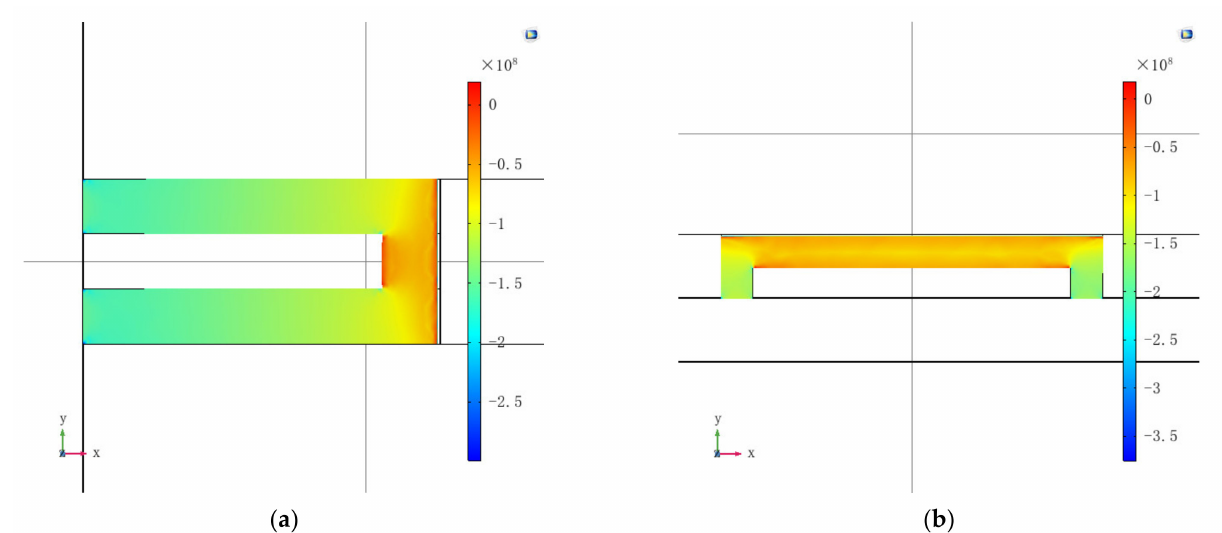
Figure 3. COMSOL simulation results for the normal force sensor. ( a ) Txx along the piezoresistor perpendicular to the edge; ( b ) Tyy along the piezoresistor parallel to the edge.